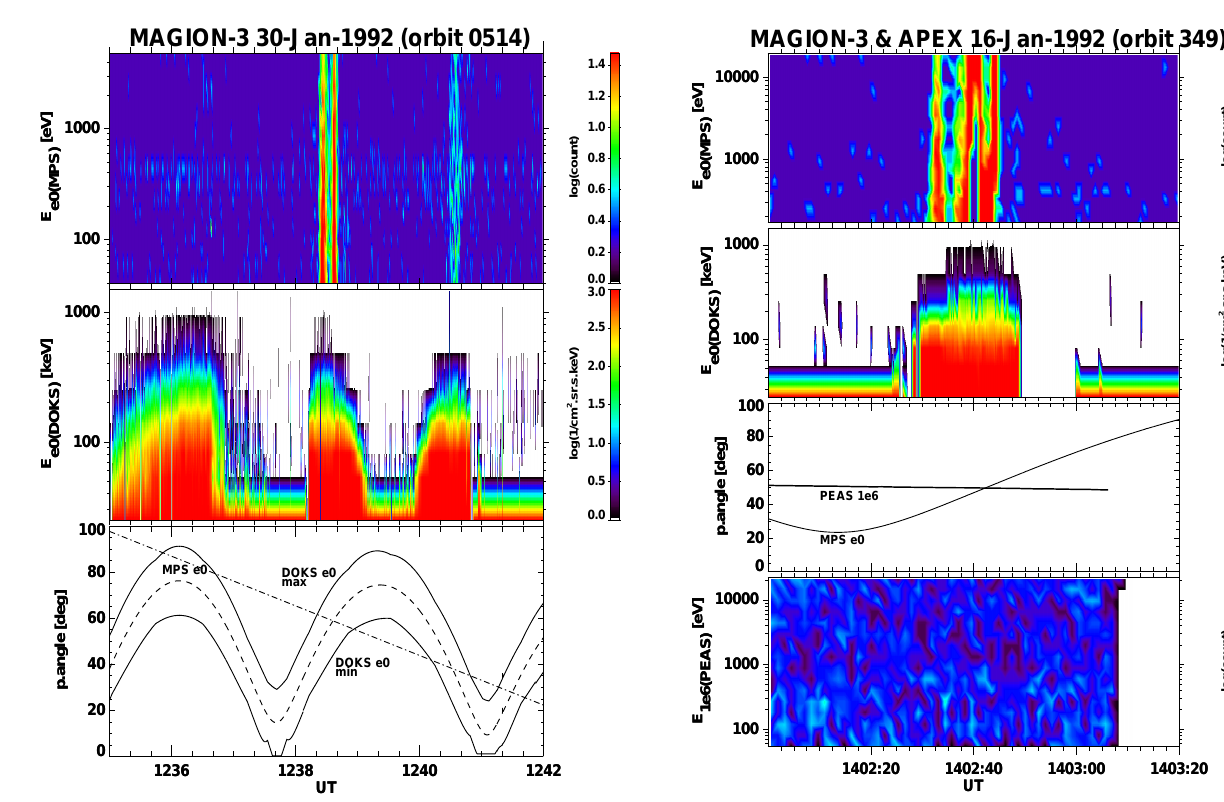
Fig. 4. Multiple observations of the electron burst (orbit No. 514). From top to bottom: E e0 ( MPS ) , dynamic spectrogram registered by MPS; E e0 ( DOKS ) , dynamic spectrogram registered by DOK; p.angle, pitch angle of MPS (MPS e0 and dashed line), the range of pitch angles covered by DOK lies between two thin curves (DOKS e0 min, DOKS e0 max), dotted-dashed line shows approximate change of burst pitch angle with the time.